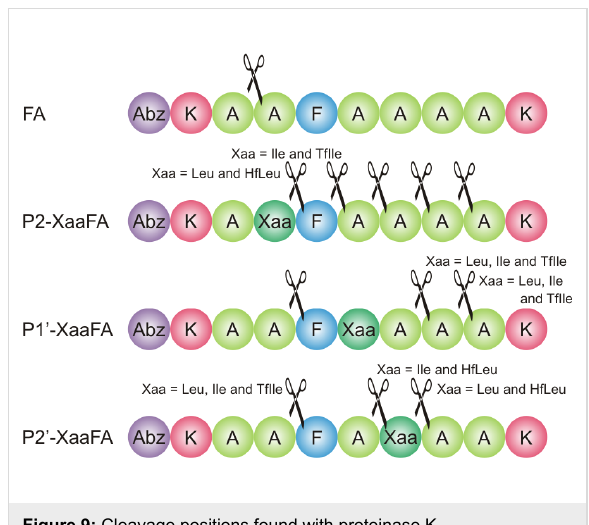
Figure 9: Cleavage positions found with proteinase K.